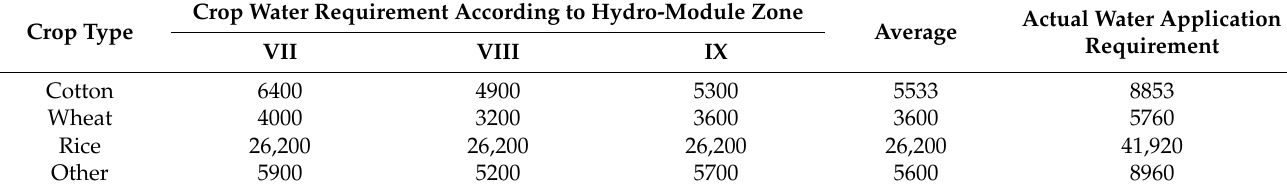
Table 1. Crop water requirements (m 3 ha − 1 ) according to hydro-module zones and actual water application requirements in the Khorezm region,